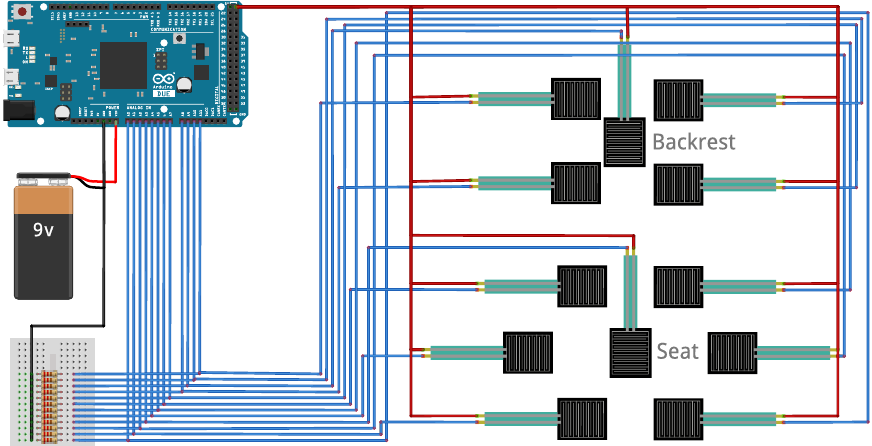
Figure 4. Electrical circuitry of the pressure sensor